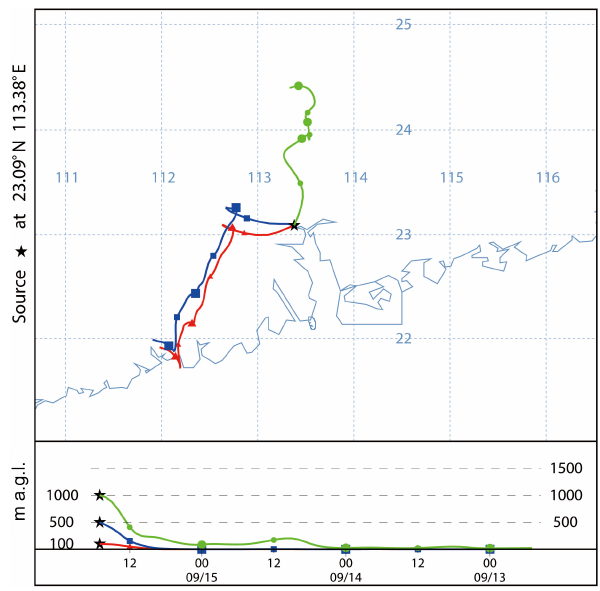
Figure 14. Backward trajectories at 100, 500, and 1000m, ending at 01:00LT on 16 September 2019, determined by the HYSPLIT model